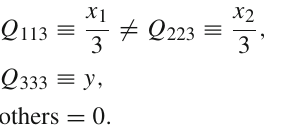
Fig. 1 Numerical integration of (26) with y = − 1 ,ε = 0 . 0001. The figure plots the values of | Ψ( x , z ) | 2 against x , z . Values over 3000 are chopped. For z we used a step of Δ z = 0 . 001 and for x a step of Δ x = 0 . 05. The function peaks around z = 0, which agrees with the expectation from the highlighting